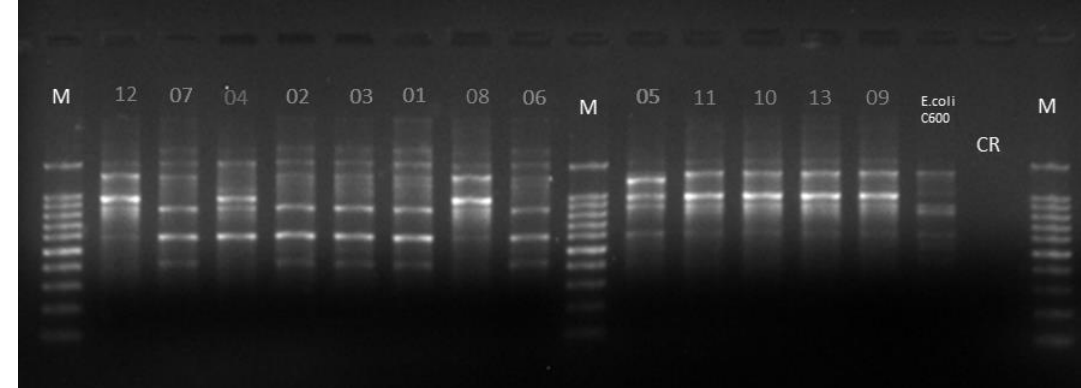
Figure 1. Genotypic relatedness of Klebsiella pneumoniae carbapenemase-producing - Escherichia coli (KPC E. coli ) isolated from trafficked Psittaciformes under captivity at the Centro de Triagem de Animais Silvestres da Paraíba (CETAS-PB), located in the Restinga de Cabedelo National Forest, Brazil.Genotype I: samples 08, 09, 10, 11, 12 and 13; Genotype II: samples 01, 02, 03, 06 and 07; Genotype III: sample 04 and Genotype IV: sample 05.